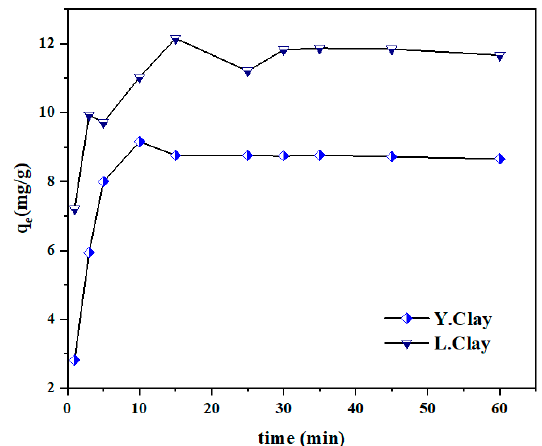
Figure 4. Effect of contact time; Conditions: m = 0.01 g, C = 12 mg/L, T = 30 °C.